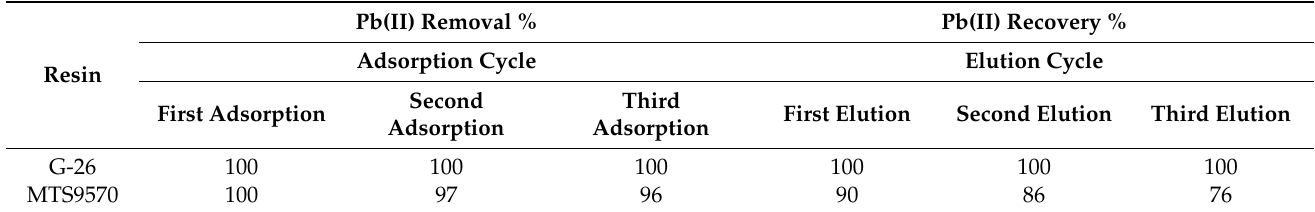
Table 6. Adsorption and desorption cycles of Pb(II) on G-26 and MTS9570